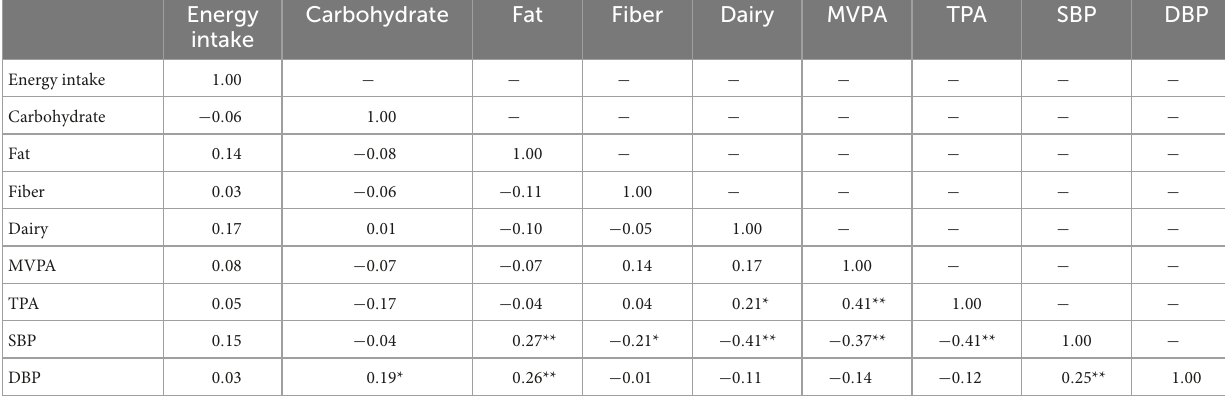
TABLE 3 Correlation coefficients between dietary, PA, and BP measures. Energy Carbohydrate Fat Fiber Dairy MVPA TPA SBP DBP intake